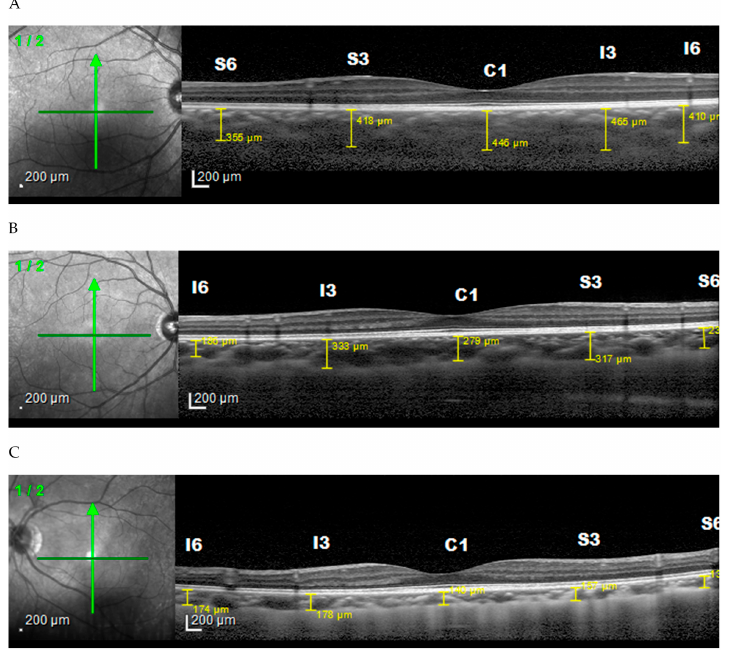
Figure 4. Choroidal thicknes based on axial length vertically. (A) Normal axis (22,47 mm) (B) Medium axis (23,75 mm), (C) Long axis (27,60 mm)